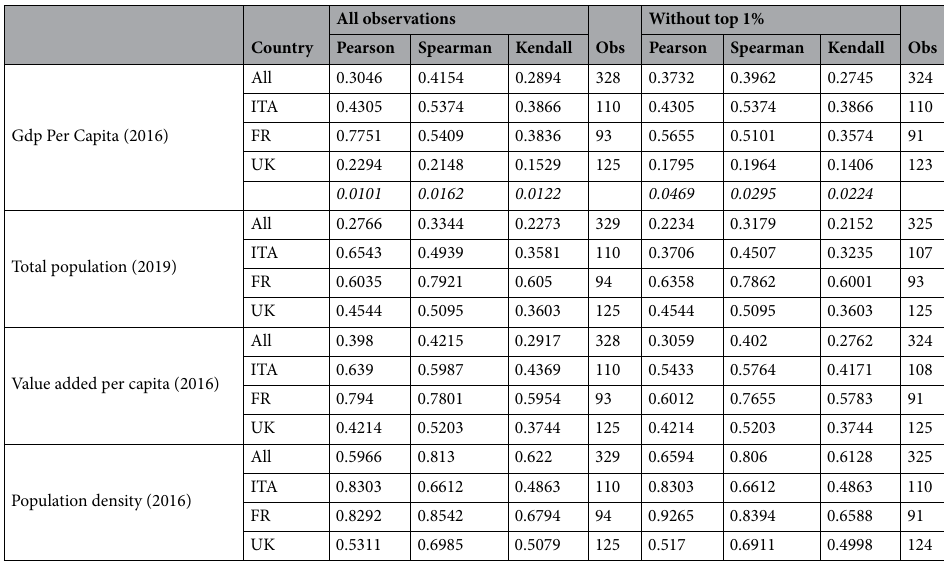
Table 1. Correlation among node persistence and economic and demographic indicators calculated for all countries together and separately on each country subset. Calculation performed on the full sample (columns on the left) and on the sample without the top percentile to avoid the influence of outliers. First row reports correlation coefficients, second row reports in italic p values only for values greater than